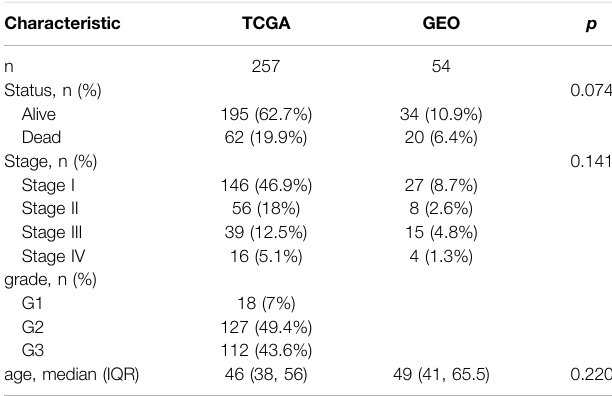
TABLE 1 | Clinical data from The Cancer Genome Atlas (TCGA) and Gene Expression Omnibus (GEO).